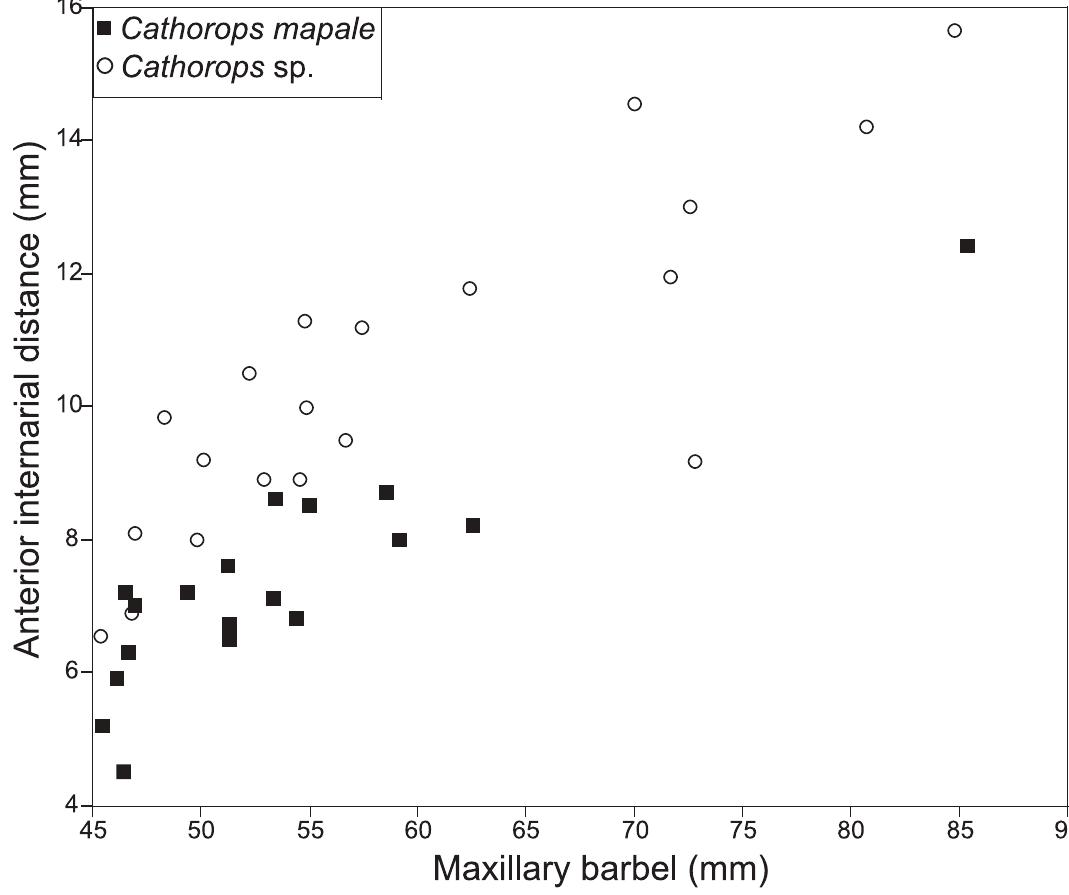
Figure 4. Best morphometric discriminator for the Cathoropsmapale group. Plot of maxillary barbel vs. posterior internarial distance.